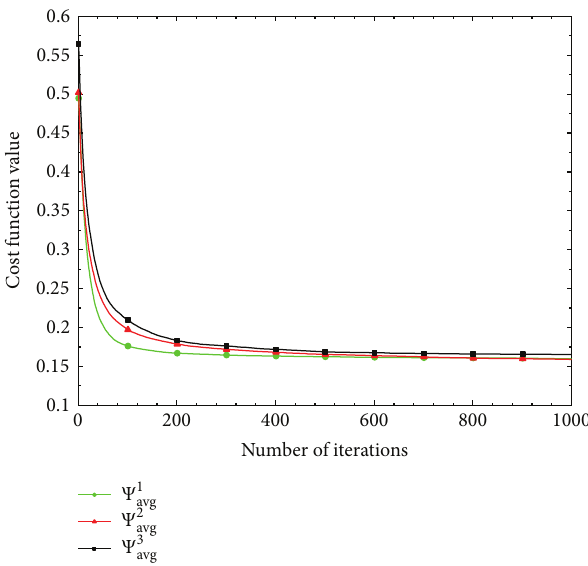
Figure 22: The average convergence behaviour of the three methods for JSCIS— Ψ 𝑘 represents the cost function value and 𝑘 represents the method used, where 𝑘 = 1 : SBL, 𝑘 = 2 : SR, and 𝑘 = 3 : SB. The mean sideband level versus iteration graph is given